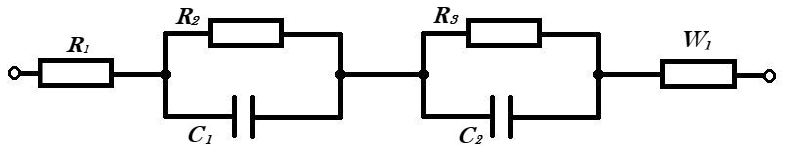
Figure 1. Electrochemical impedance equivalent circuit model.